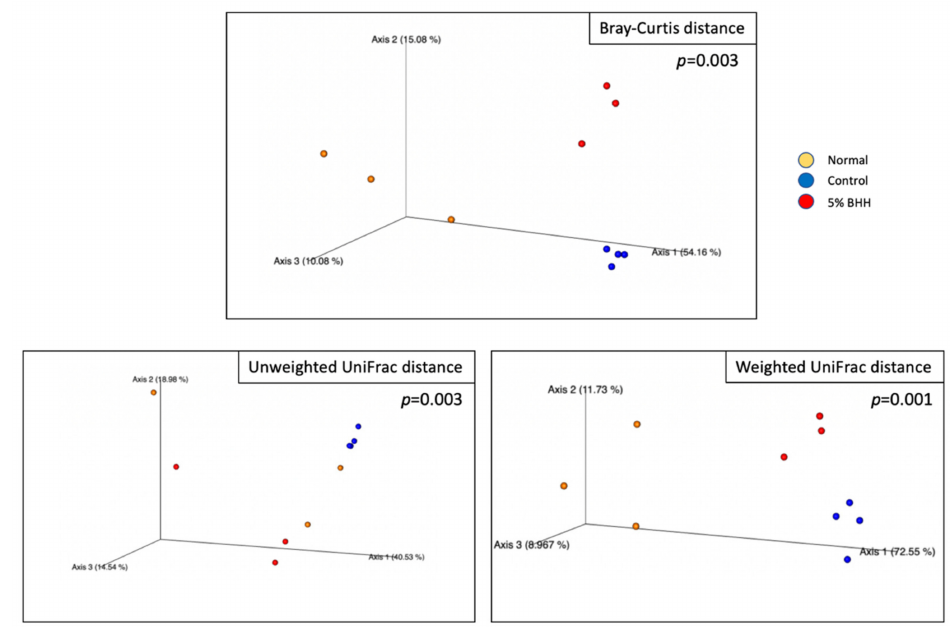
Figure 4. Visualization of PCoA 3D plots based on Bray–Curtis distance, unweighted UniFrac distance, and weighted UniFrac distance by EMPeror. The p -value by Kruskal–Wallis test in all groups. Yellow marker, Normal; blue marker, Control; red marker, 5% BHH.